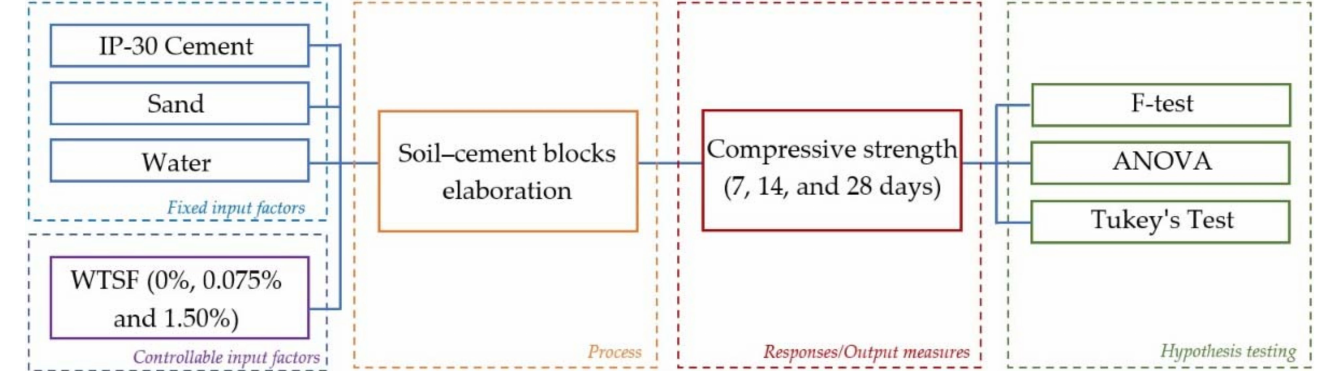
Figure 2. Research methodology.